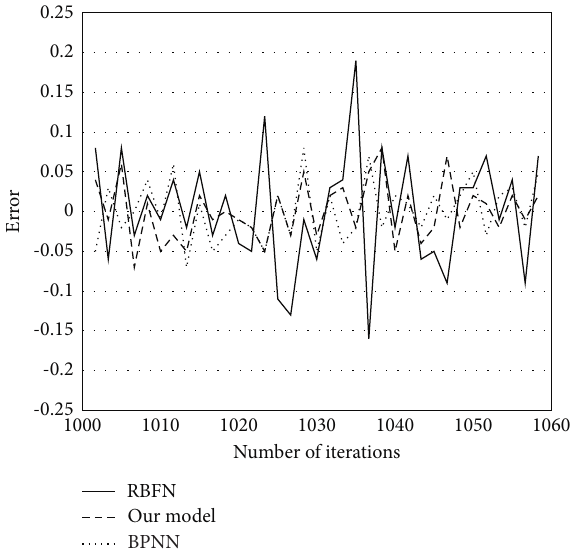
Radial basis function network (RBFN) Figure 6: Training error curves.